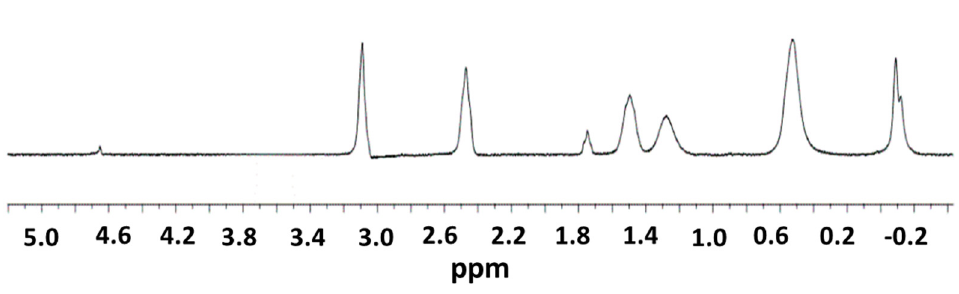
Figure 4. 1 H-NMR of G 3 Si(SC 2 H 4 NH)(SCH 2 CO 2 Na) 31 (III) in D 2 O.